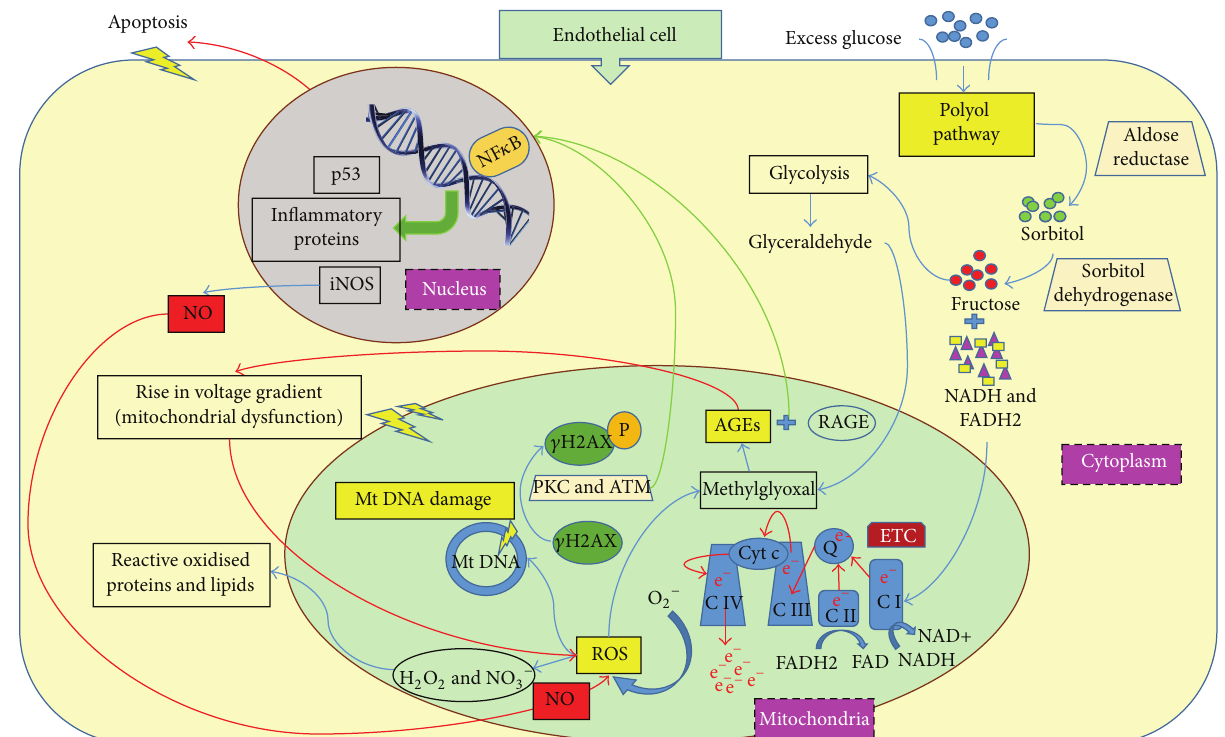
Figure 2: Mechanisms of hyperglycemia-induced endothelial dysfunction. Key processes responsible for hyperglycemia-induced endothelial dysfunction include the polyol pathway, reactive oxygen species (ROS) formation, and advanced glycation endproducts (AGEs) formation. The excess glucose in endothelial cells enters polyol pathway; the electron donors like reduced nicotinamide adenine dinucleotide (NADH) and Flavin adenine dinucleotide (FADH2) accumulate in the mitochondria, thus affecting the electron transport chain; the excess electrons increase ROS in mitochondria; ROS triggers accumulation of AGEs; ROS and AGEs create mitochondrial DNA damage and mitochondrial dysfunction; protein kinase C (PKC) and AGE mediated activation of nuclear factor kappa B (NF 𝜅 B) activate the expression of inflammation proteins, tumor suppressor p53, and inducible nitric oxide synthase (iNOS); increased nitric oxide (NO) by iNOS is highly reactive with superoxide anions; the peroxynitrite thus generated acts as a strong oxidant and completes the vicious cycle of oxidative stress by increasing ROS production; accumulation of AGEs also increases ROS production independent of glucose